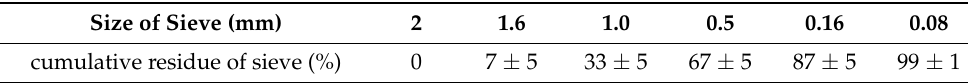
Table 3. Particle size distribution of ISO standard sand (ISO